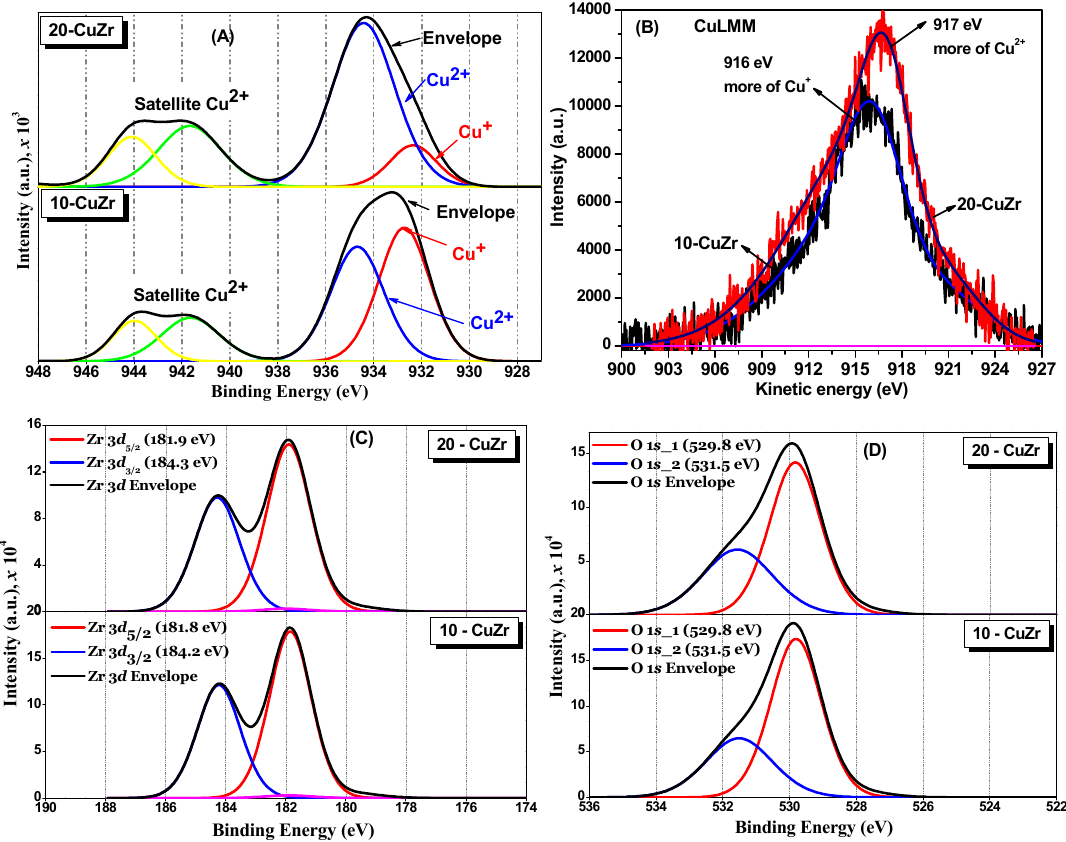
Figure 6. ( A ) Cu 2p ( B ) CuLMM Auger ( C ) Zr 3d and ( D ) O 1s XP spectra for CuZr samples.